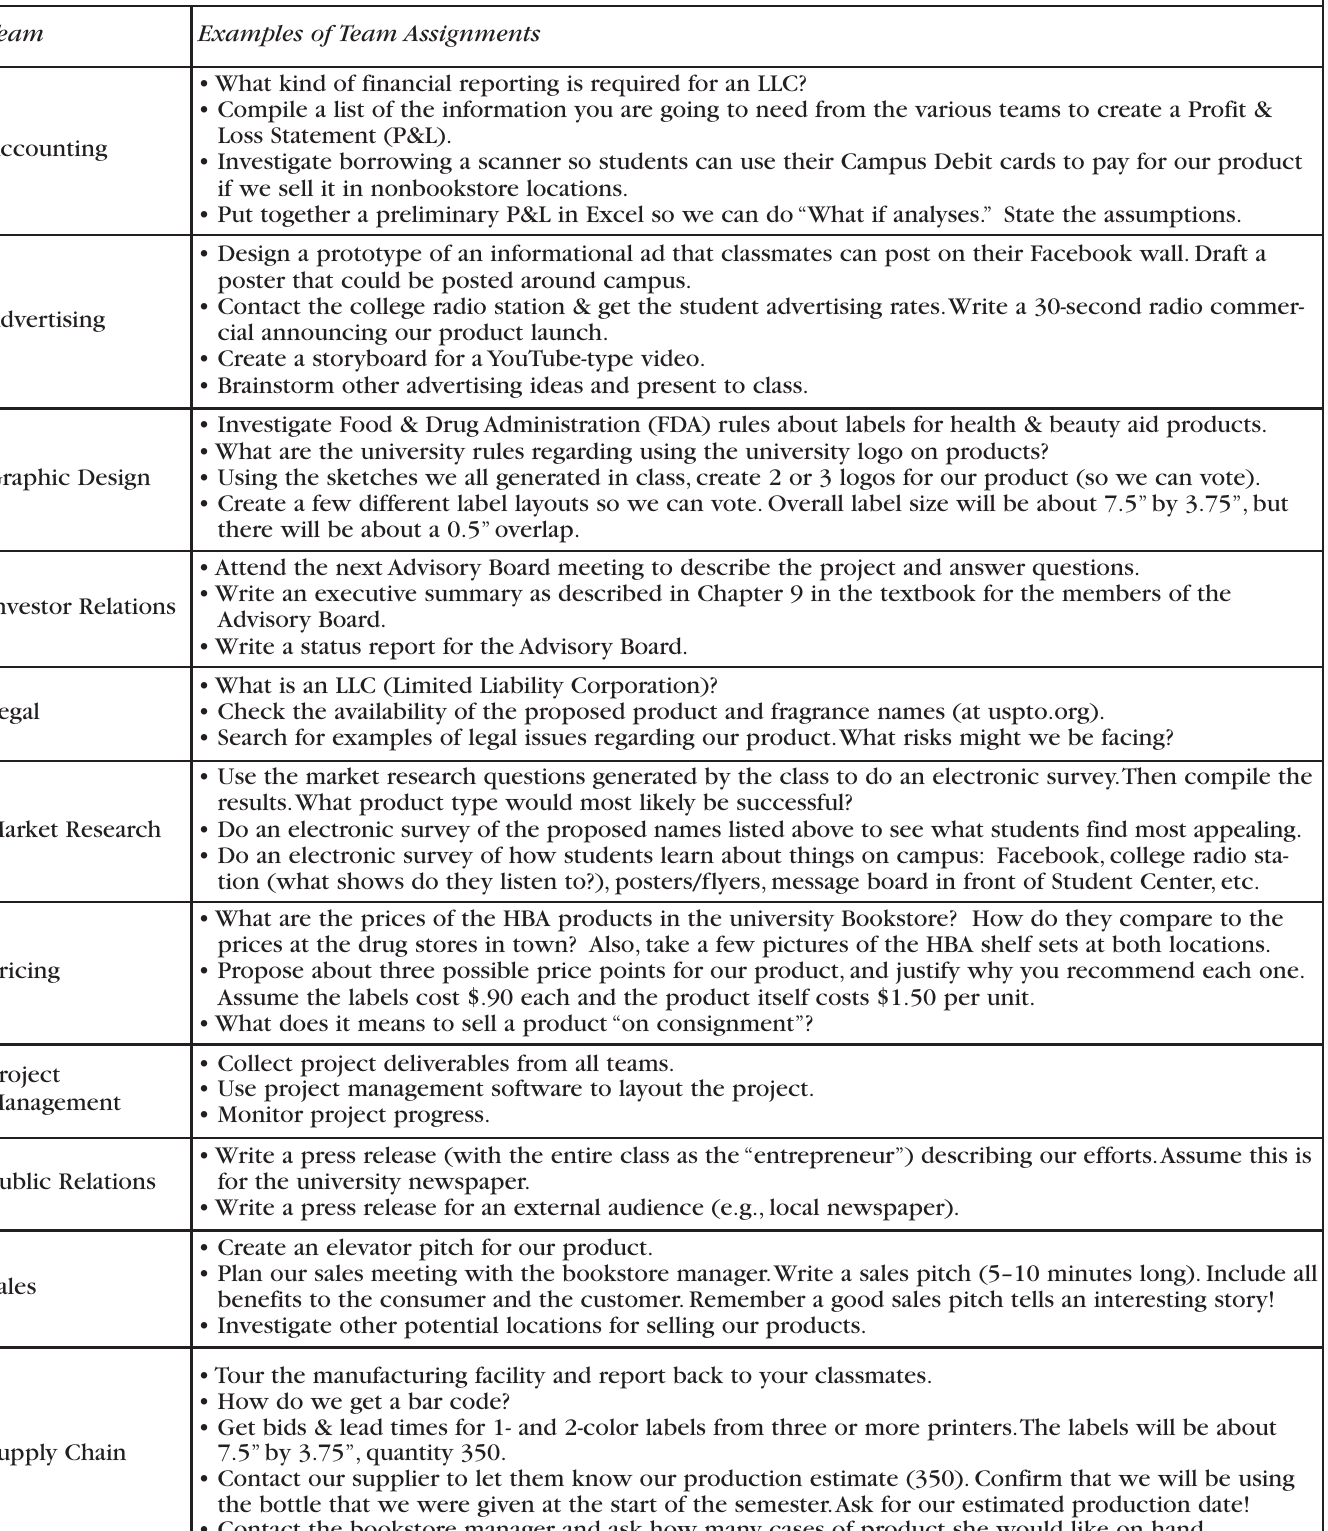
Table 1. Sample Team